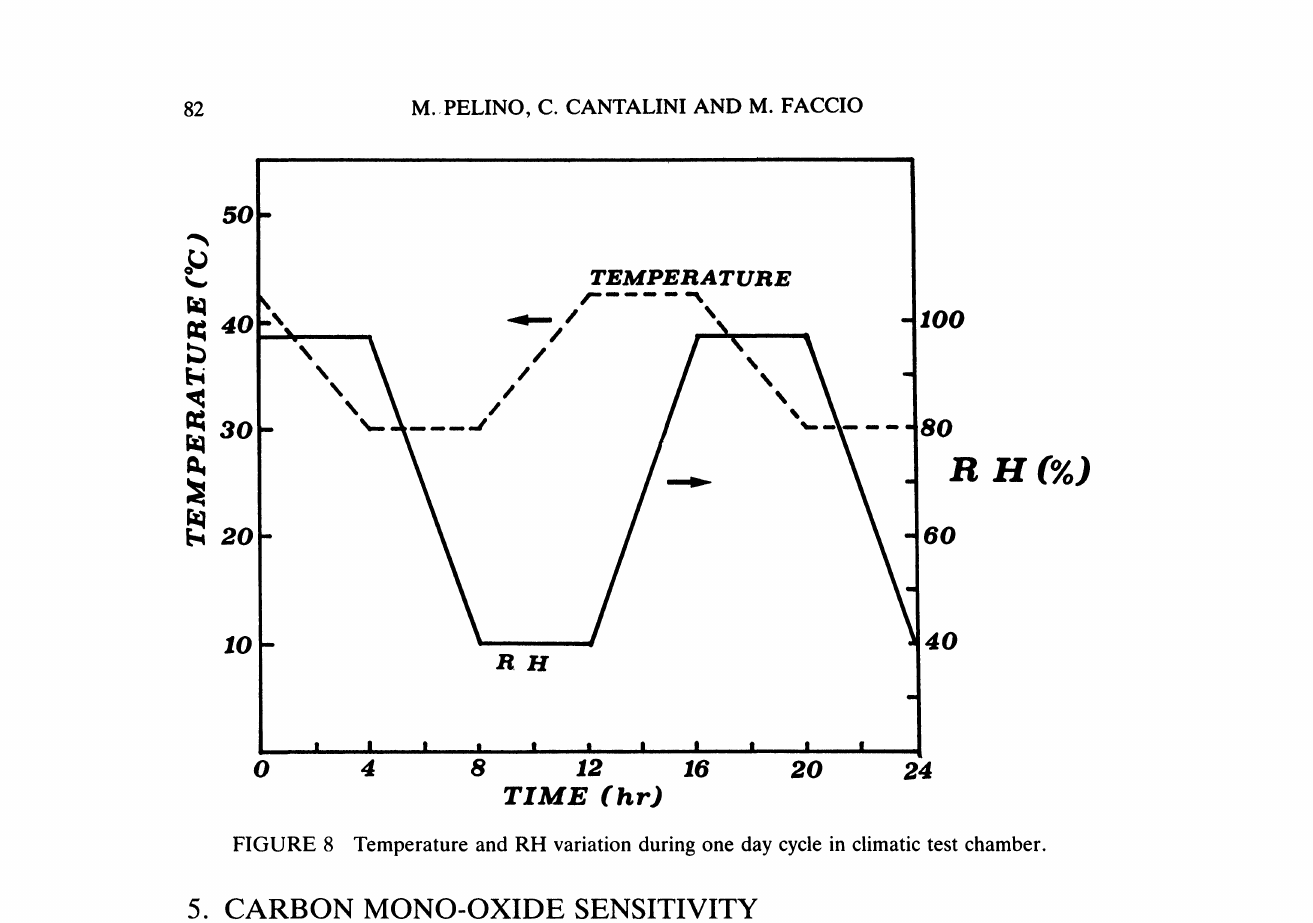
FIGURE 8 Temperature and RH variation during one day cycle in climatic test